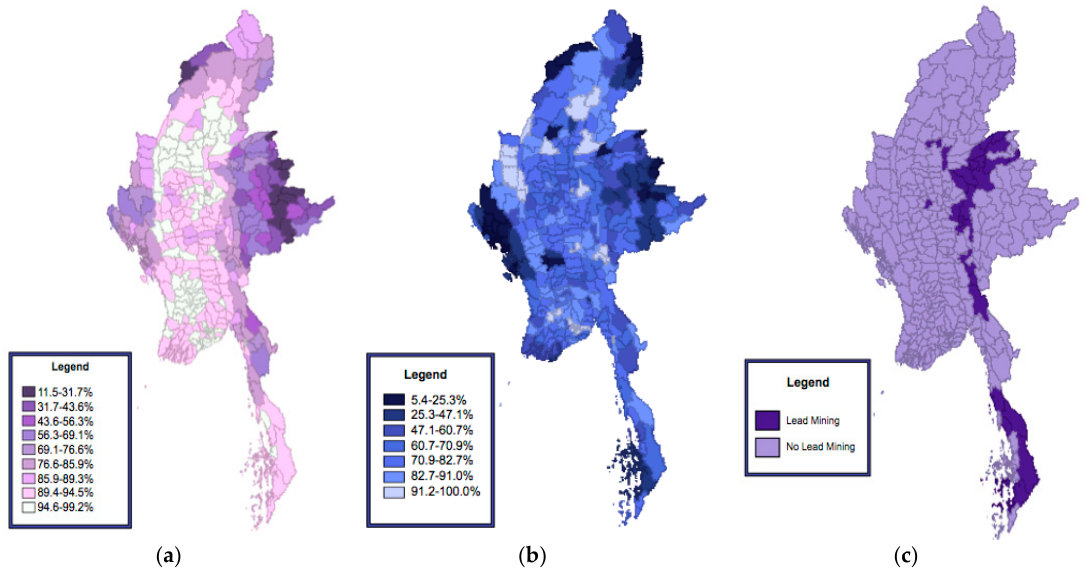
Figure 1. Descriptive maps of Myanmar visually representing adult literacy levels ( a ), access to safe sanitation ( b ), and lead mining activity status ( c ). Both access to safe sanitation and adult literacy levels were mapped using natural breaks calculated through GeoDa, while the lead mining map represents dichotomous variables.